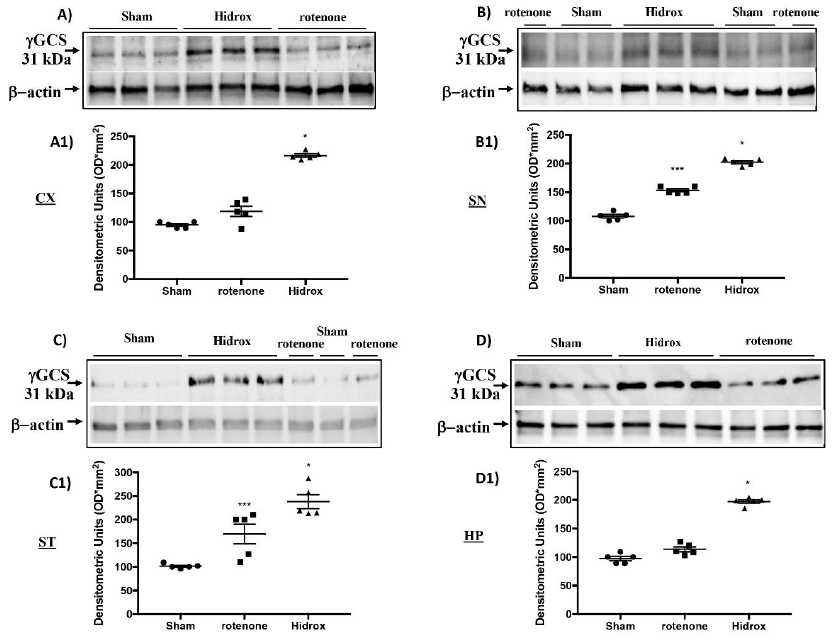
Figure 6. E ff ects of HD on the γ -GCS protein after rotenone intoxication. Western blot analysis showed that the expression of γ -GCS increased insignificantly in the rotenone group in the CX ( A , A1 ) and HP ( D , D1 ) areas, while there was a significant increase in the ST ( C , C1 ) and SN ( B , B1 ) regions. HD treatment further significantly increased the expression of Hsp-70 ( A – D1 ). The data are expressed as the mean ± SEM from N = 5 mice/group. ( A1 ) * p < 0.05 vs. rotenone; ( B1 ) * p < 0.05 vs. rotenone; *** p < 0.001 vs. Sham; ( C1 ) * p < 0.05 vs. rotenone; *** p < 0.001 vs. Sham; ( D1 ) * p < 0.05 vs. rotenone.